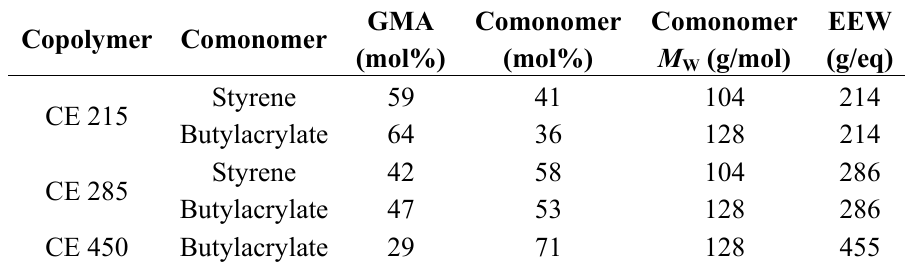
Table 2. Estimation of mole percent of Glycidyl methacrylate (GMA) in the copolymers (reactive